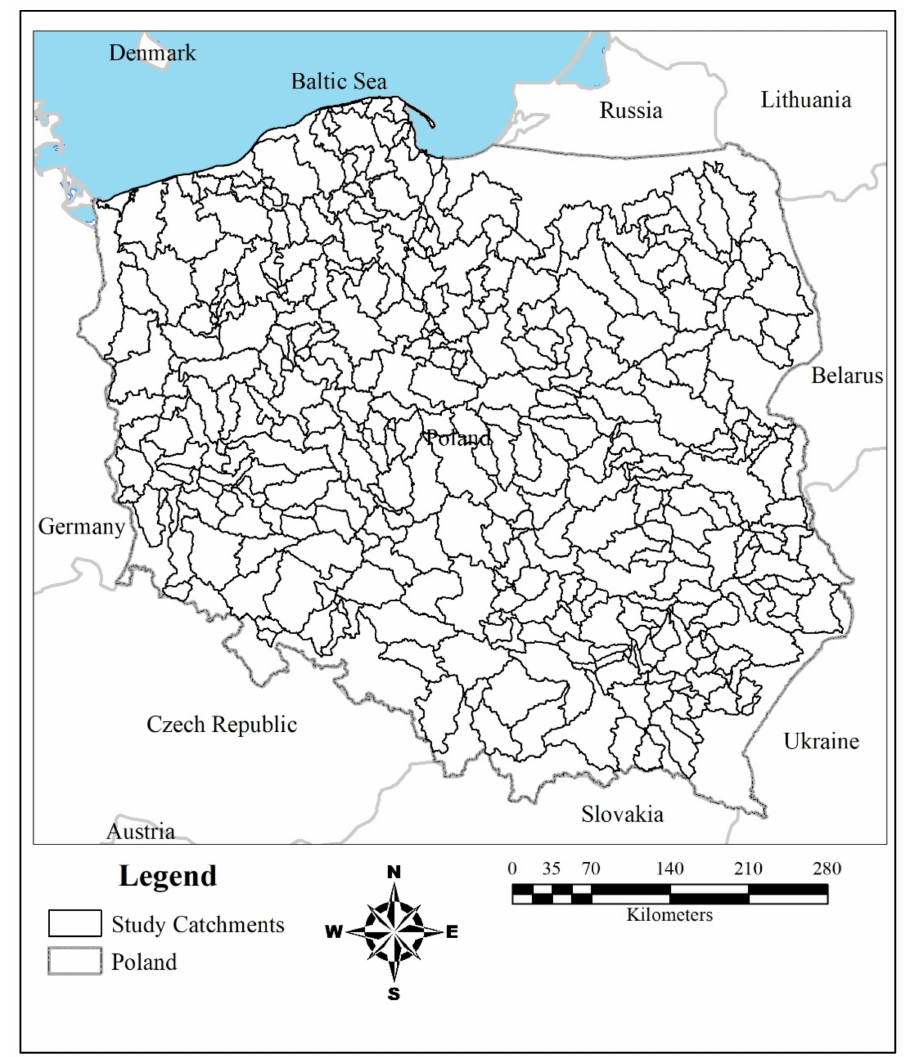
Figure 1. The geographical position of the study catchments in